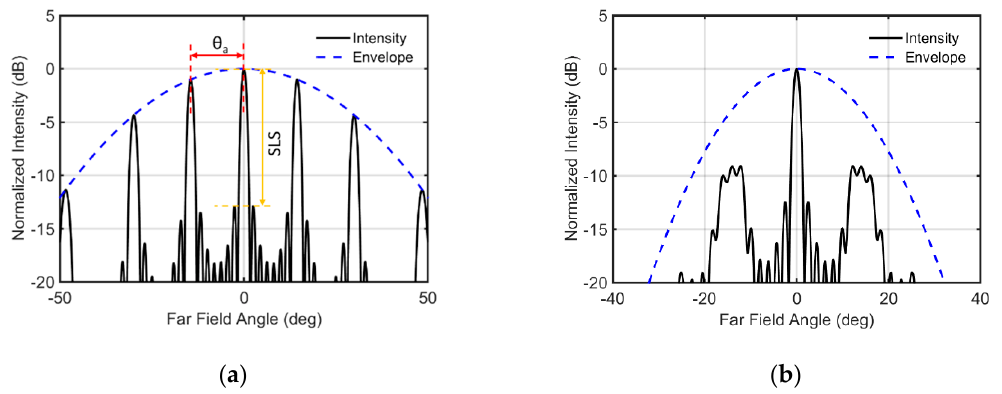
Figure 3. Simulated far field intensity distribution and antenna diffraction envelope for an OPA of 8 antennae ( a ) with uniform spacing of 4 λ and antenna full divergence angle (Gaussian beam approximation) of 60 ◦ ; and ( b ) with unequal spacing from 3 λ to 5 λ and antenna full divergence angle of 30 ◦ .